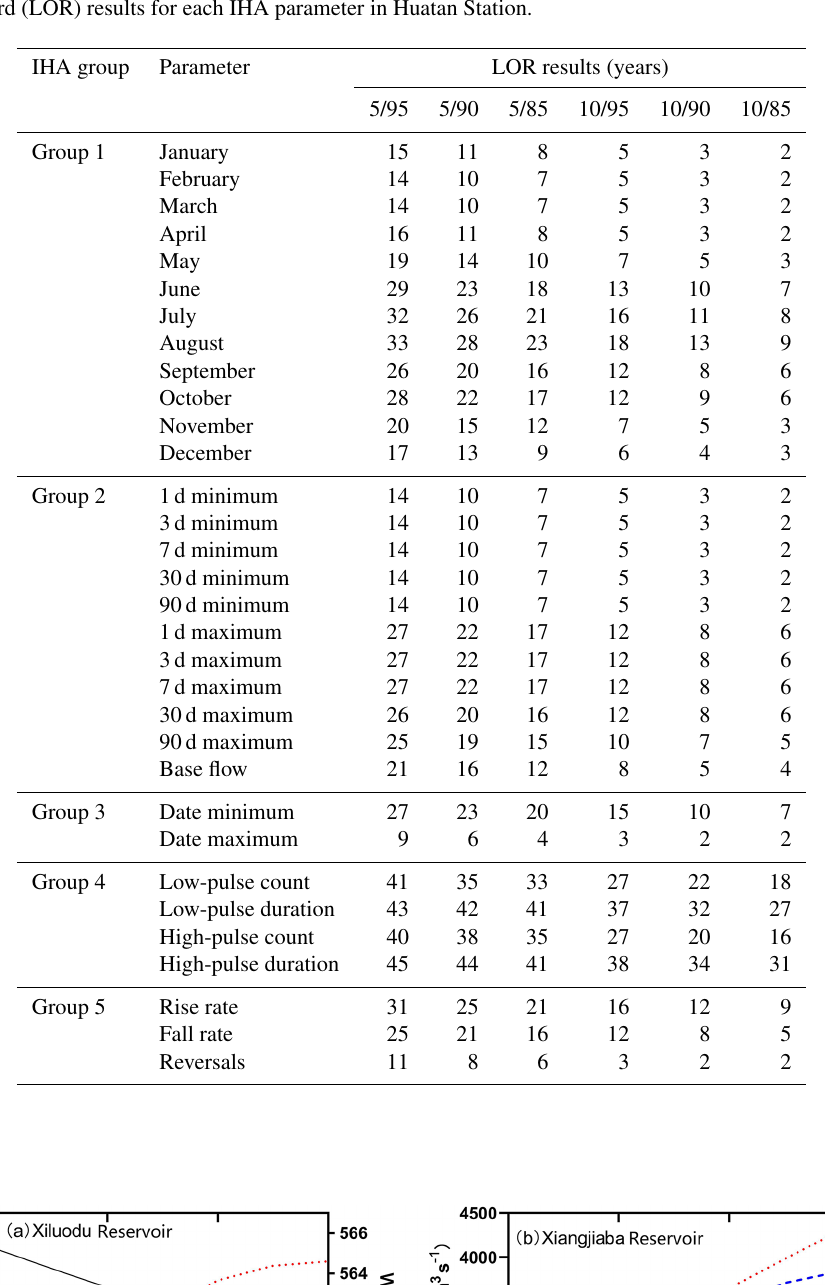
Table 8. Length of record (LOR) results for each IHA parameter in Huatan Station.